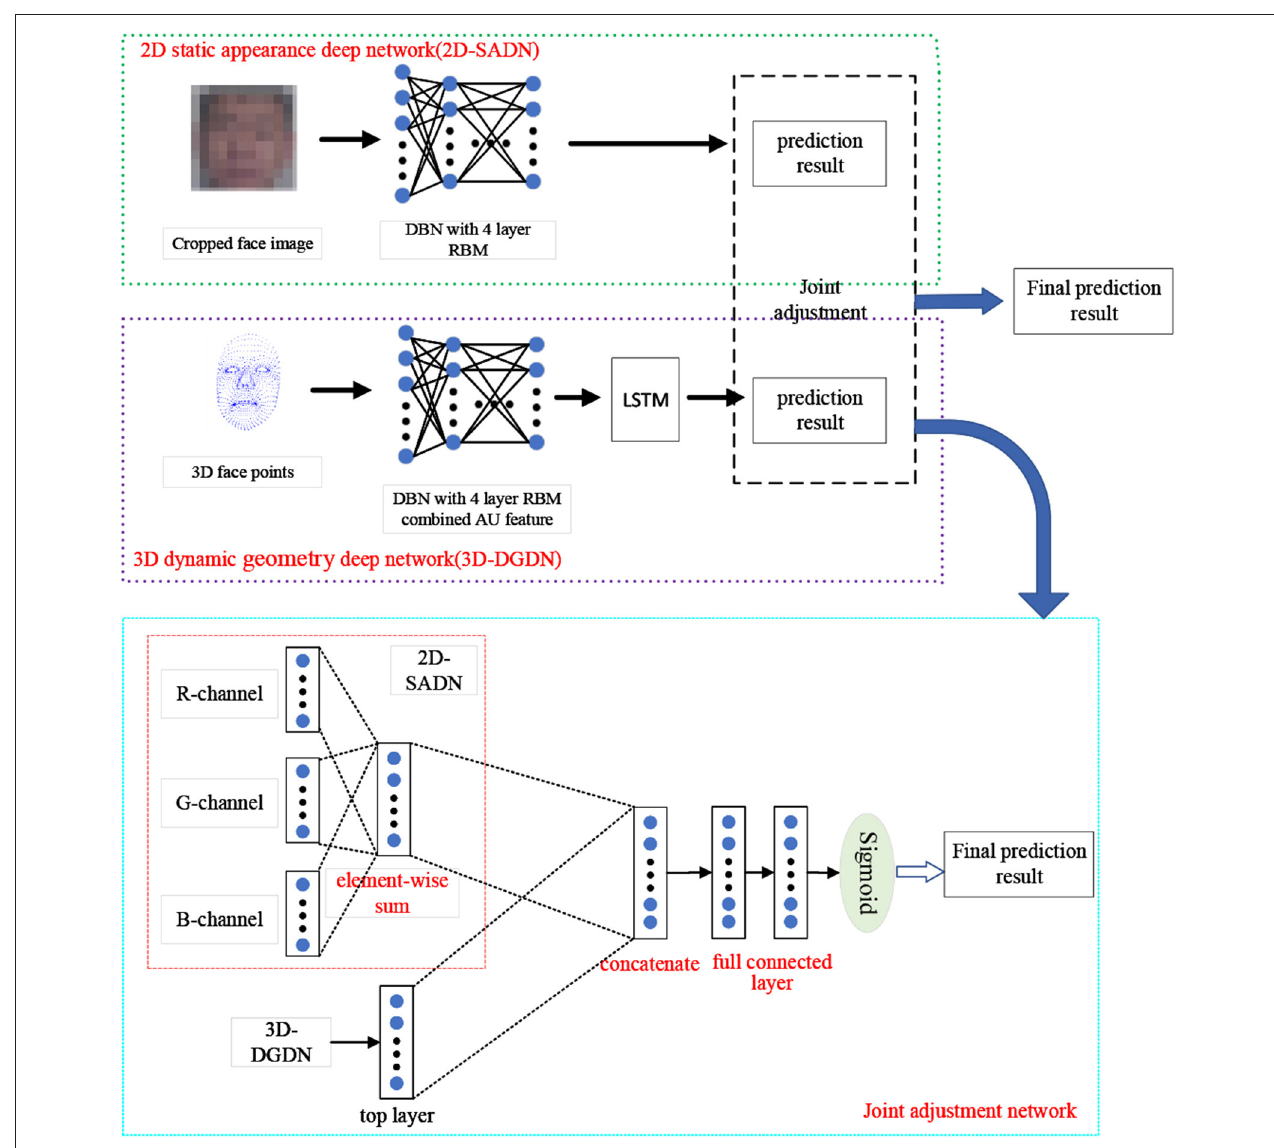
FIGURE 2 | The framework of proposed approach.